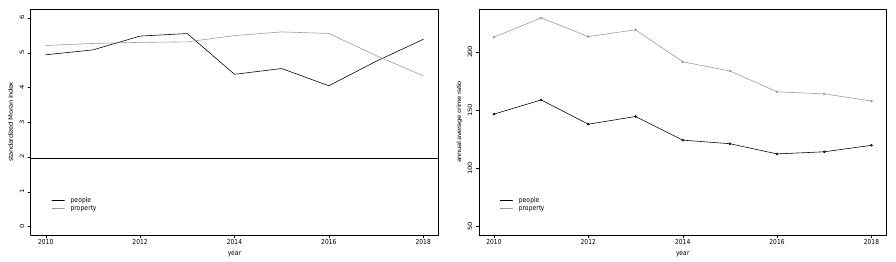
Figure 2. Moran indices ( left ) and annual averages ( right ) for the ratios of both crimes type